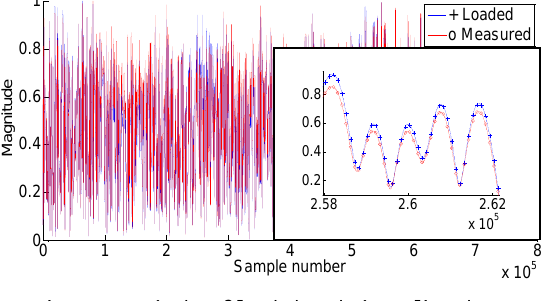
Fig. 3 Magnitude of loaded and time aligned measured data under connection-1